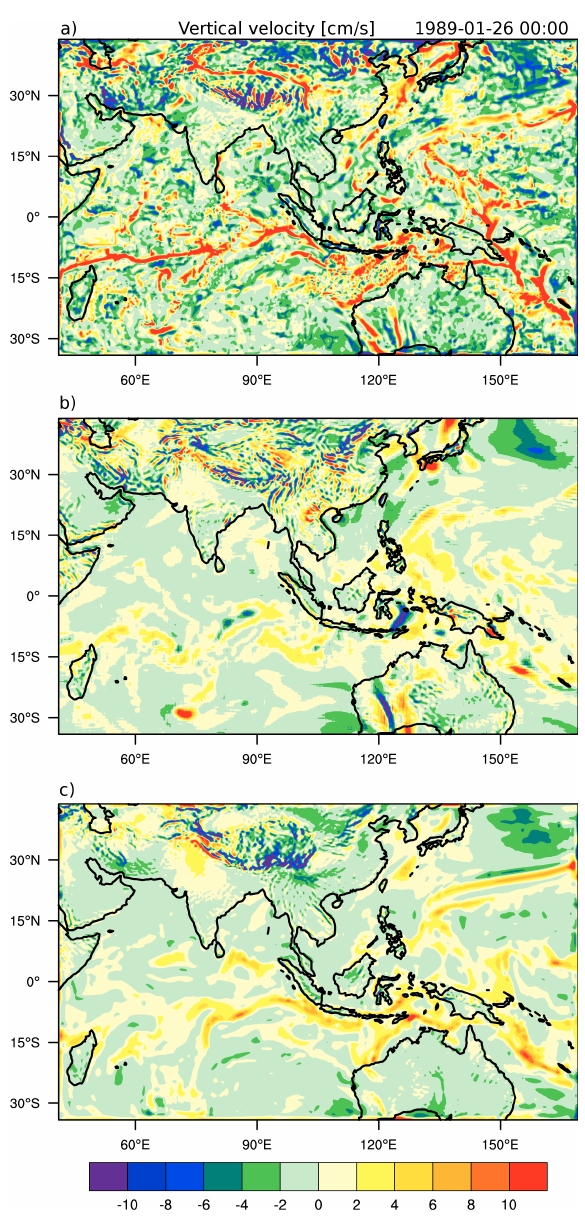
Fig. 3. (a) Vertical velocity w for level 20 of the five-day forecast from 21 January 1989 for the terrain-following model LM; (b) as (a) , for the zero-day forecast from 26 January (“verification”); (c) as (a) , for the cut-cell model LMZ.